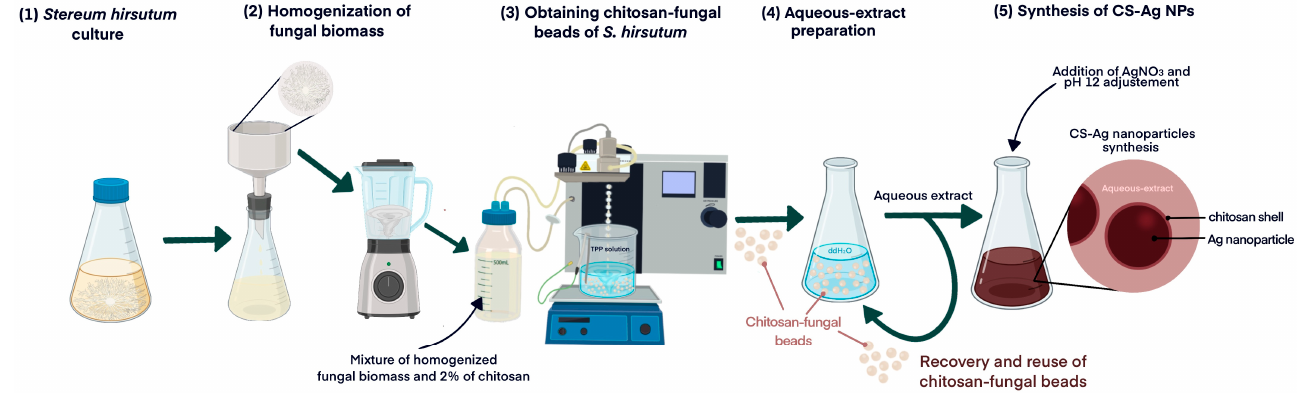
Figure 1. Diagram of the process of obtaining chitosan fungal beads using chitosan and the subse- quent synthesis of CS-Ag NPs.